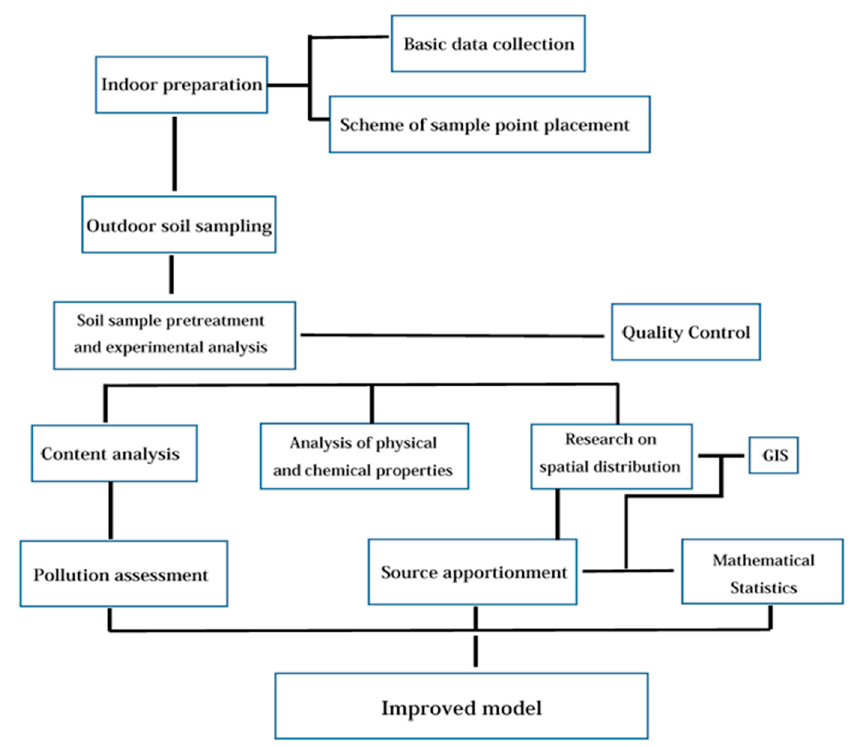
Figure 1. Research level and structure.